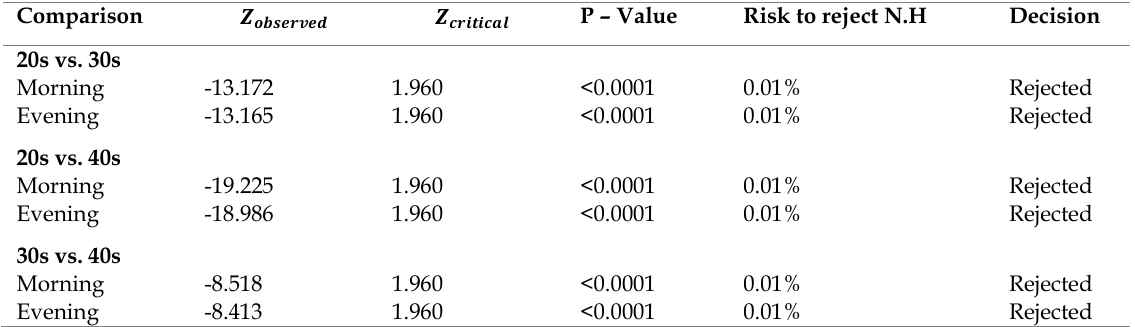
Table 6. Statistical Examination of 20s, 30s and 40s Peak Pedestrian Flows